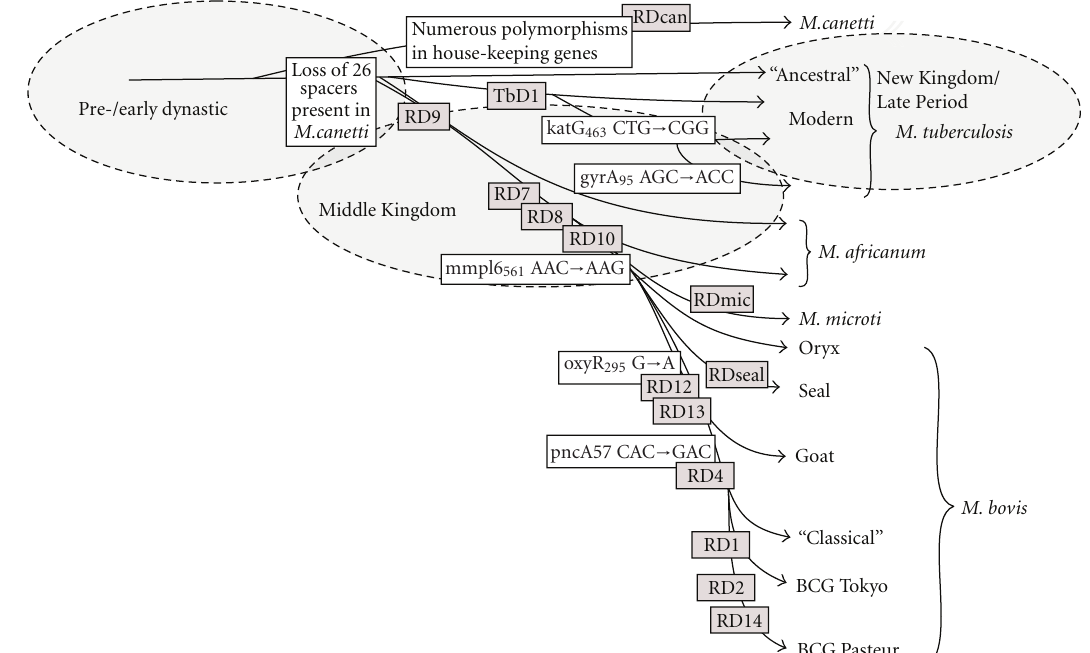
Figure 1: Schematic diagram of the potential evolution of the various tuberculosis strains (modified according to Brosch et al. [3]) and its impact on ancient Egyptian findings . The circles indicate the presumed location of the TB main strains as identified by spoligotyping and typical mutations in the various ancient Egyptian populations.